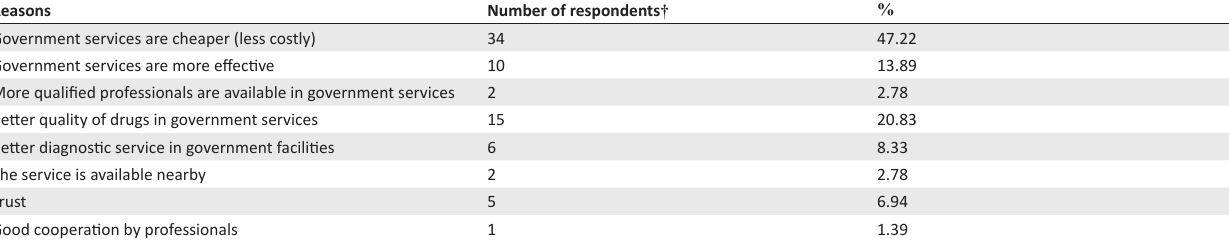
TABLE 3: Reasons indicated by farmers for preference of government service. Reasons